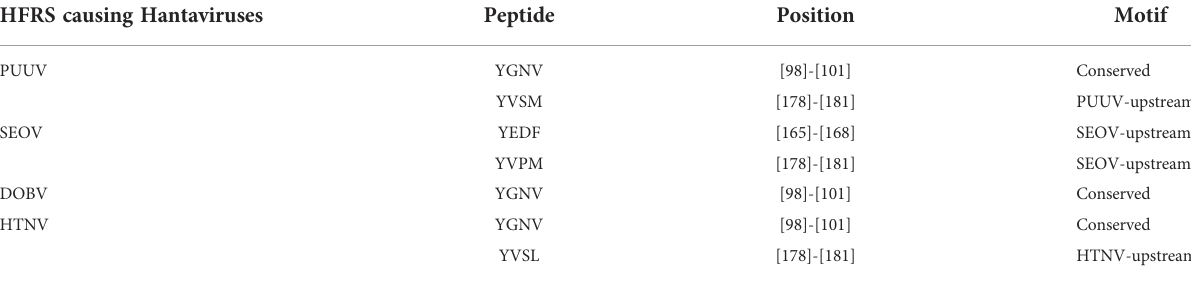
TABLE 1 Canonical YXX F [I/L/M/F/V] motifs within nucleoprotein sequences of HFRS causing Hantaviruses. HFRS causing Hantaviruses